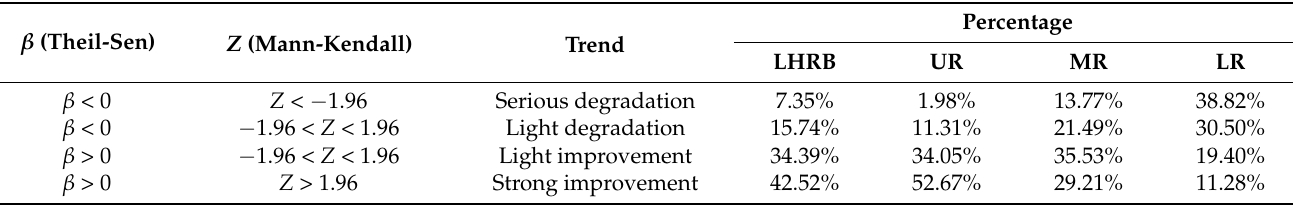
Figure 8. Trends of EQ change from 2001 to 2020 ( a ) result of trend analysis, ( b ) imagery comparison of a mining area in Chengde, ( c ) imagery comparison of an urban area in Qianan. Table 3. Trends of EQ change in different regions from 2001 to